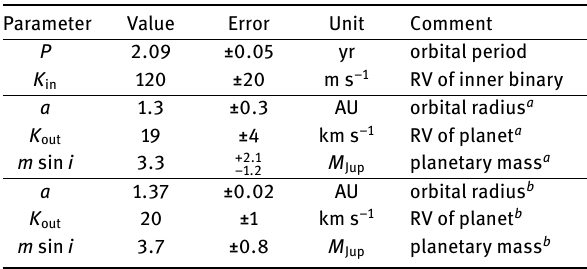
Table 2. Orbital parameters of the sdB+dM inner binary (‘in’) + po- tential circumbinary planet system (‘out’), as derived from pulse timing measurements.